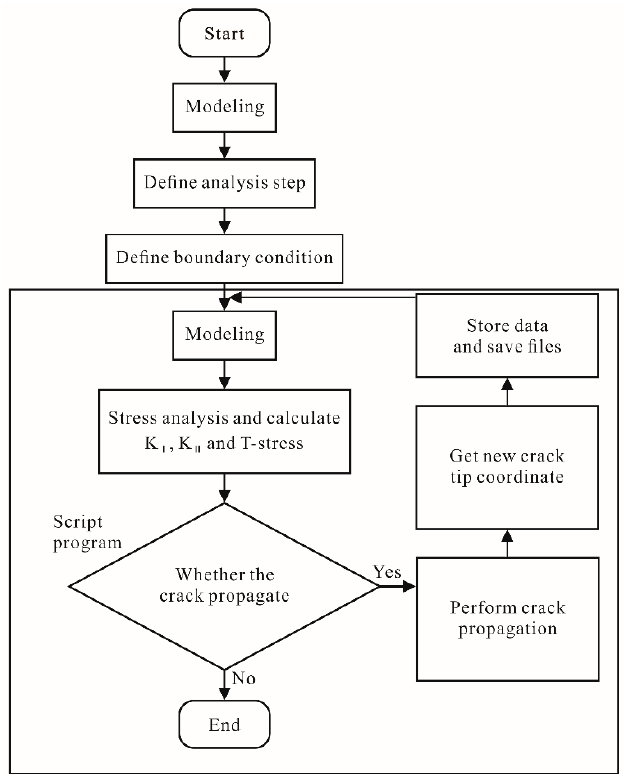
Figure 4. Process of the simulation. [19].